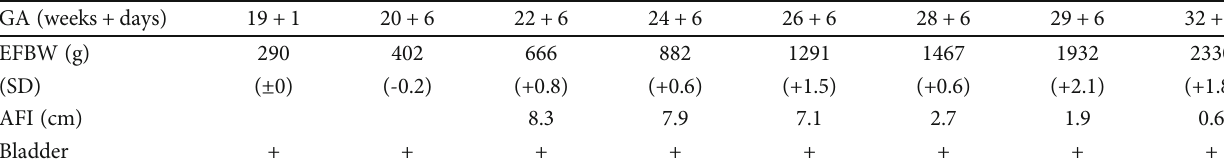
Table 1: Prenatal fi ndings of the present case.